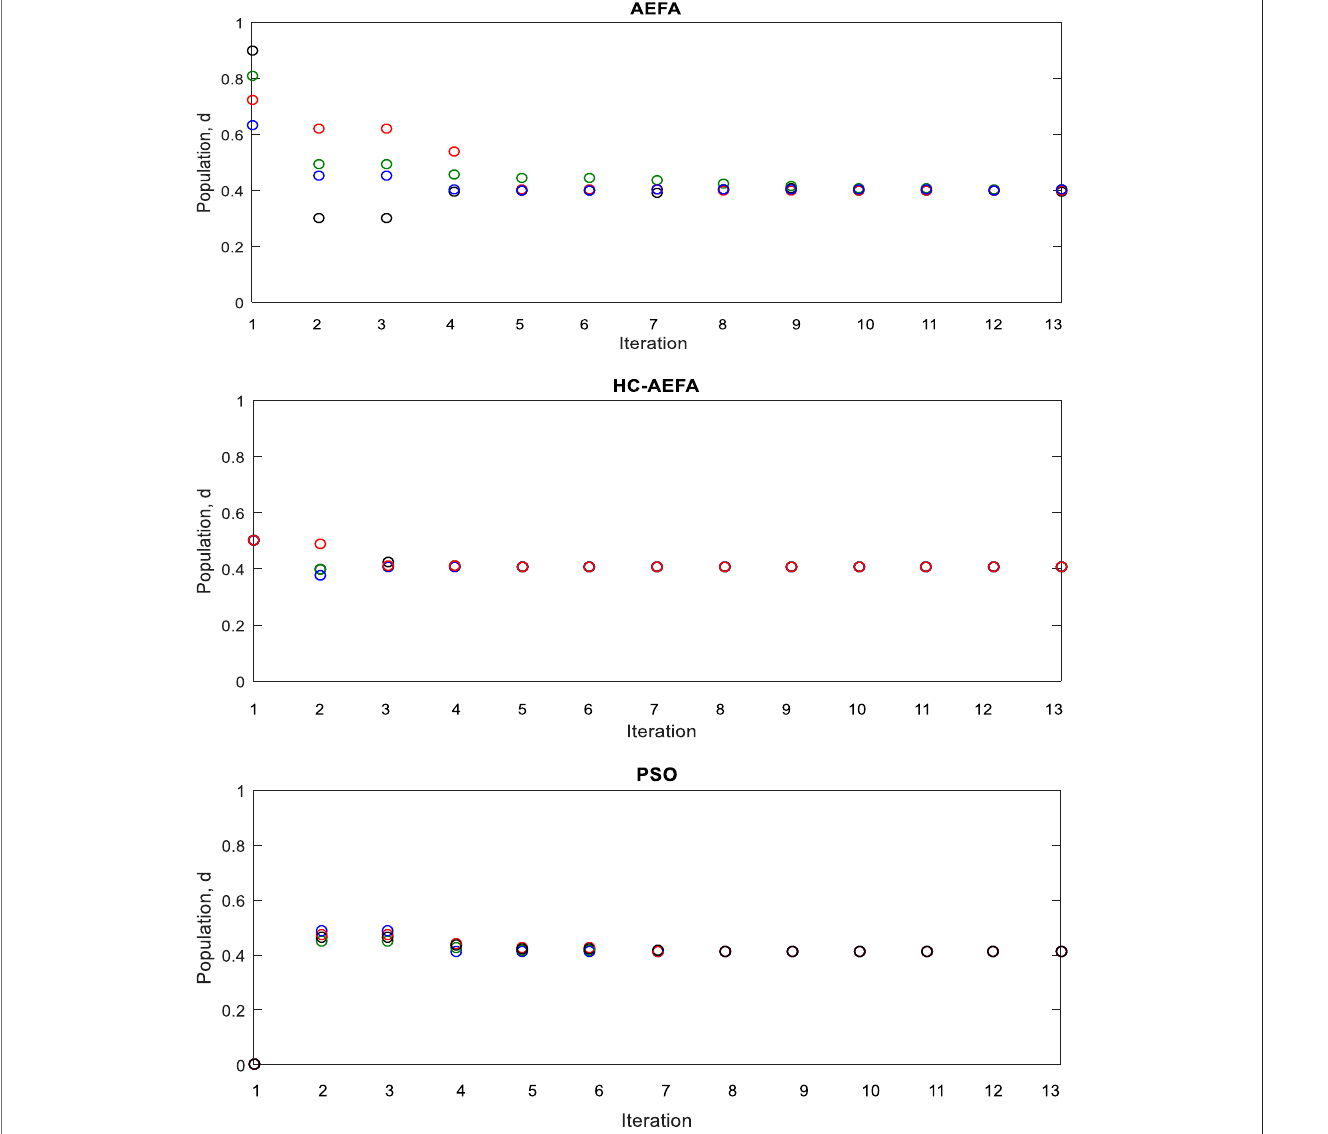
TABLE 3 | Results for the different MPPT methods in second